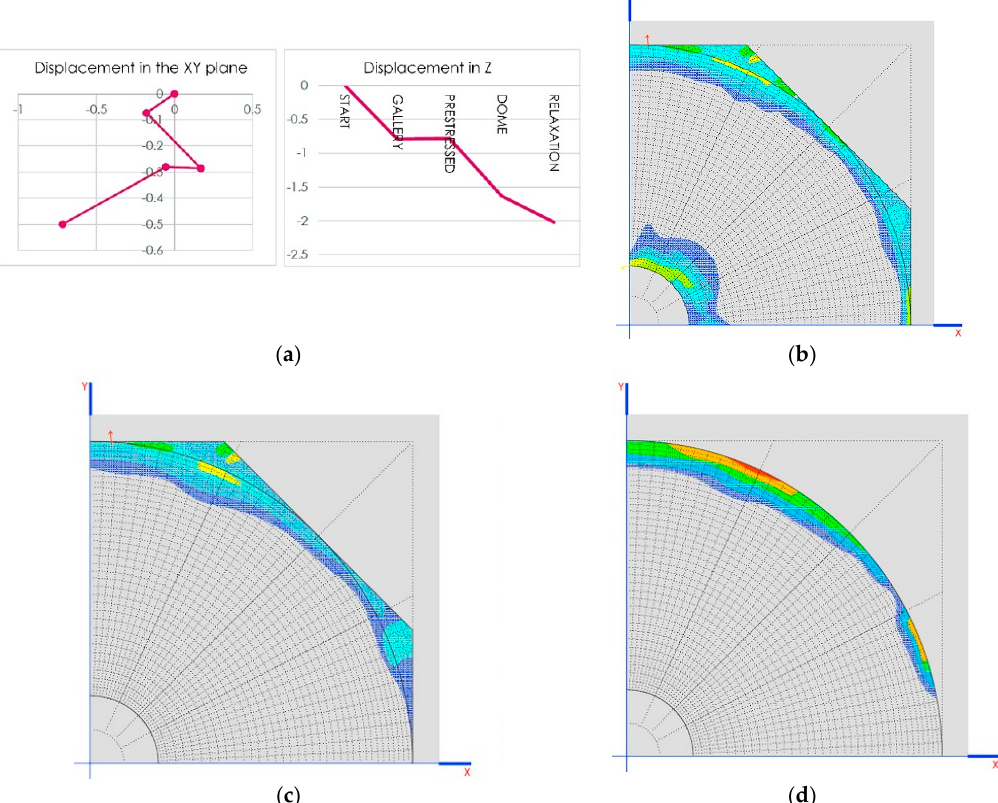
Figure 13. ( a ) Diagram of the displacement of the connecting rod support (mm); ( b ) traction in the dome (MPa) in the penultimate phase of construction; ( c ) tractions in the dome (MPa) in the last phase of construction; ( d ) behavior of the dome without the tympanums working.